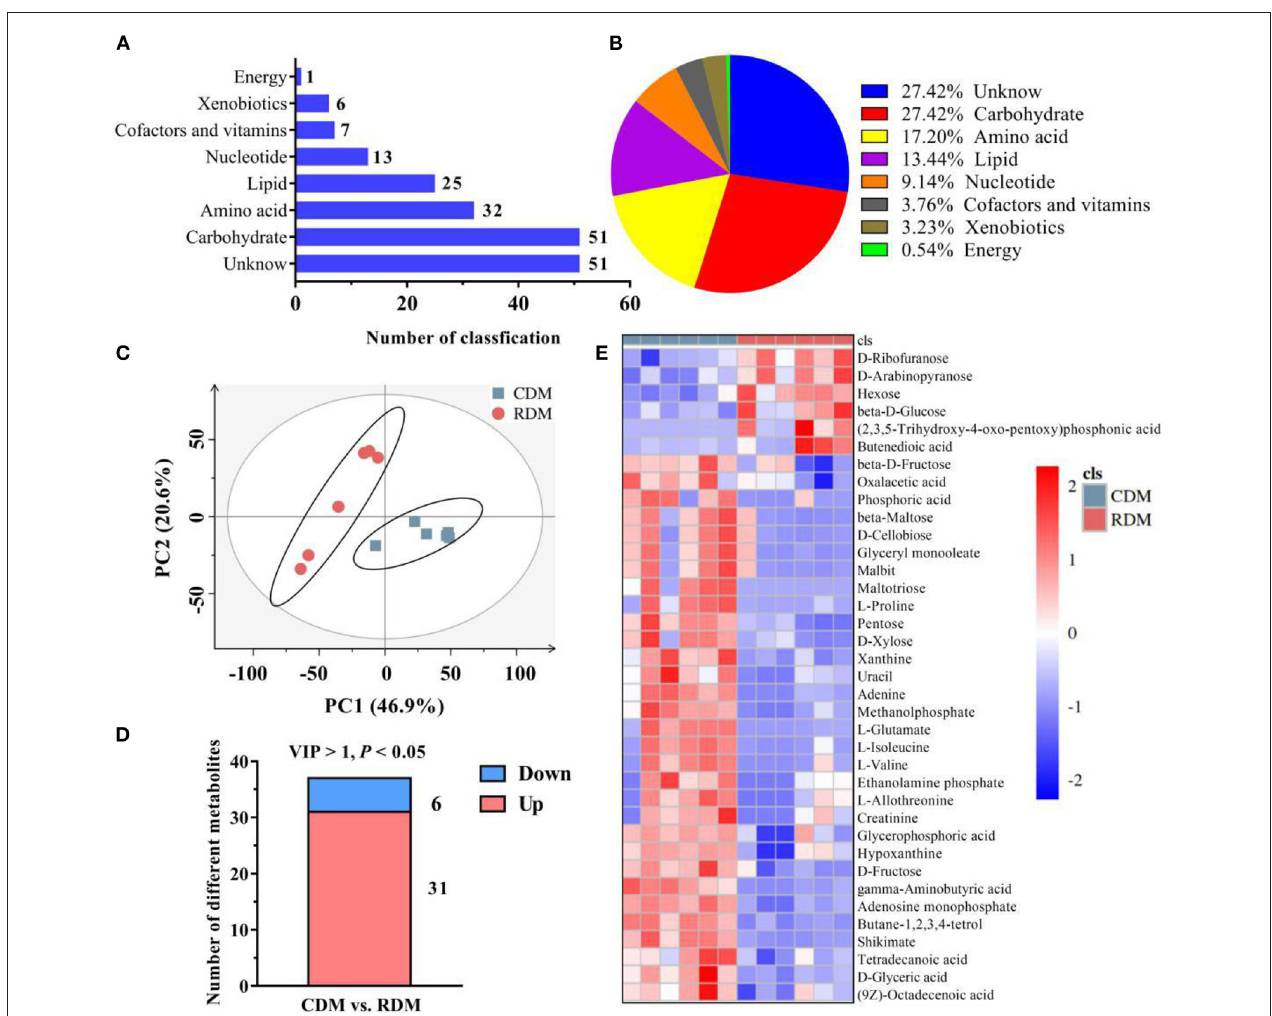
FIGURE 1 | Overall metabolic profiles and different metabolites in cooked and raw donkey muscles. (A,B) The number (A) and percentage (B) of metabolites in muscles. (C) Principal component analysis (PCA) based on metabolic data from cooked and raw muscles. (D) The number of significantly different metabolites in CDM vs. RDM. (E) Heatmap analysis of different